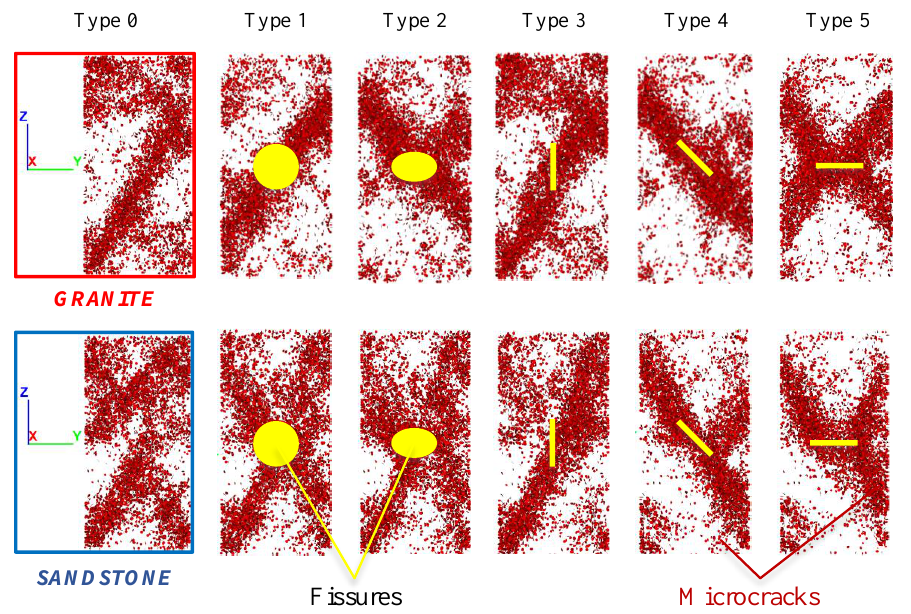
Figure 5. Fracture modes of rock samples under PSC. Fissure dip angle: Only the fracture surface of the rock sample with a type 4 fissure coincided with its fissure surface, while the fracture surface of other rock samples did not follow their fissure surface. The damage criteria of rock structural surface can be